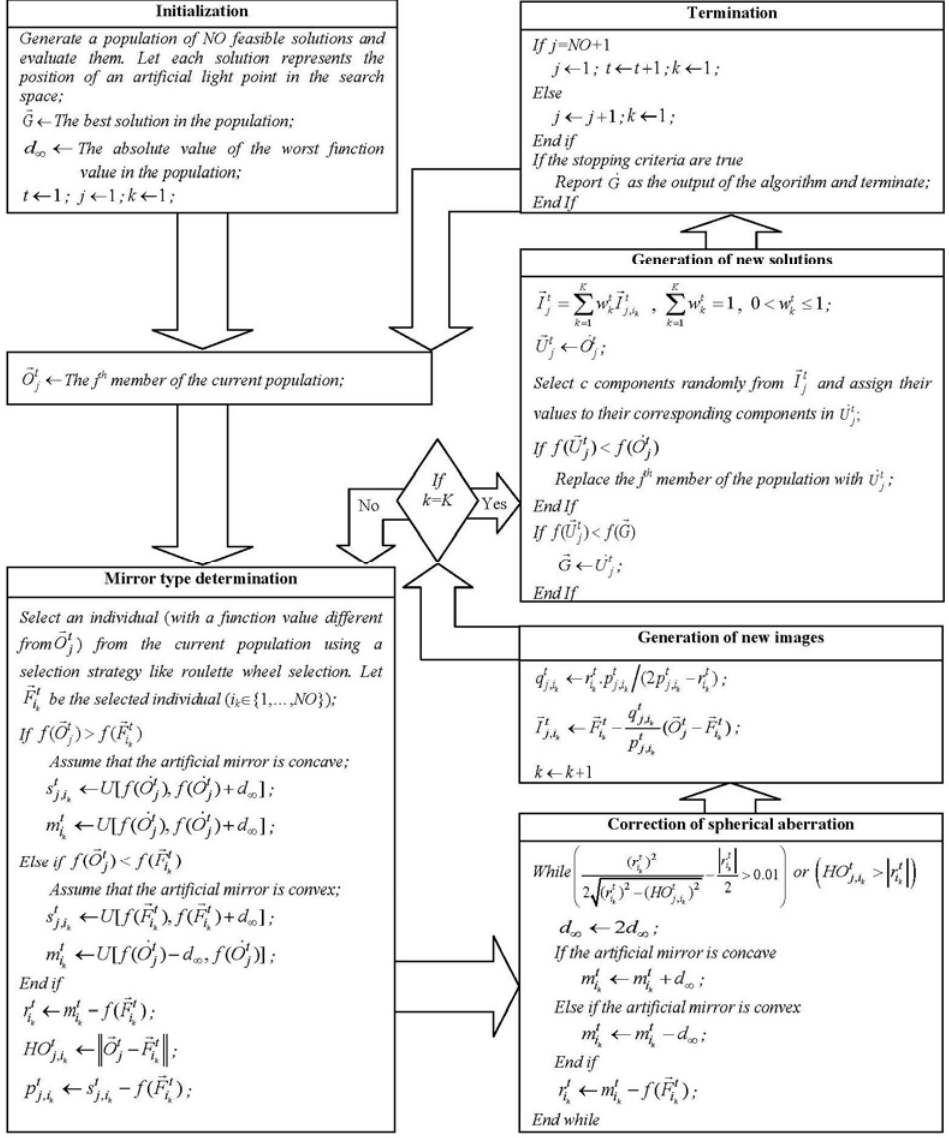
Figure 2. Flowchart of basic Optics Inspired Optimization (OIO) algorithm [37,38].